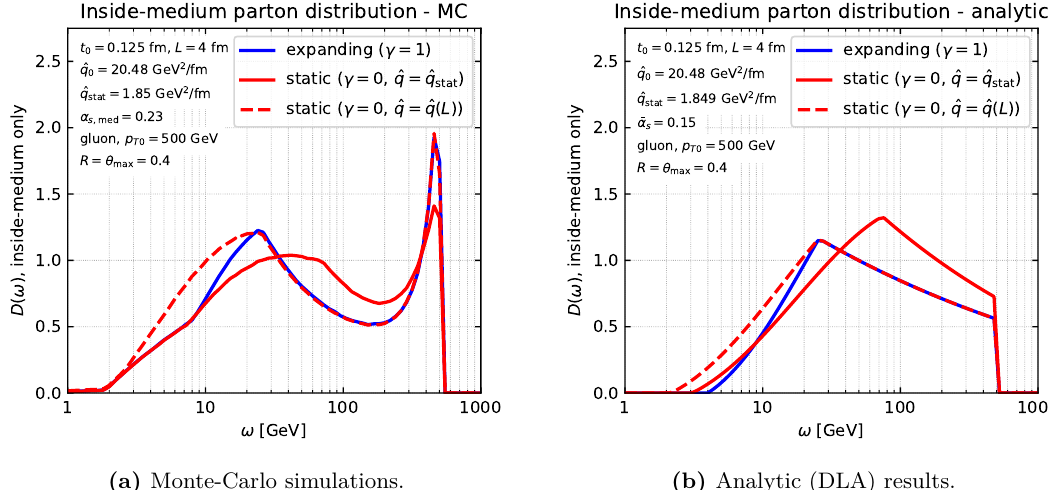
Figure 4. Parton energy distribution D ( ω ) ≡ ω (d N/ d ω ) in a parton shower exclusively generated via VLEs inside the medium: (a) Monte Carlo simulations; (b) analytic results within the double- logarithmic approximation with fixed coupling. The leading parton is a gluon with p T 0 = 500 GeV and the jet radius is R = 0 . 4 . The solid blue lines correspond to the an expanding medium with γ = 1 ; the red lines correspond to a static ( γ = 0) medium, with either ˆ q = ˆ q stat (solid lines), or ˆ q = ˆ q ( L ) (dashed lines). The contribution from the leading parton (a peak at ω ’ p T 0 = 500 GeV) is not included in the analytic plot.